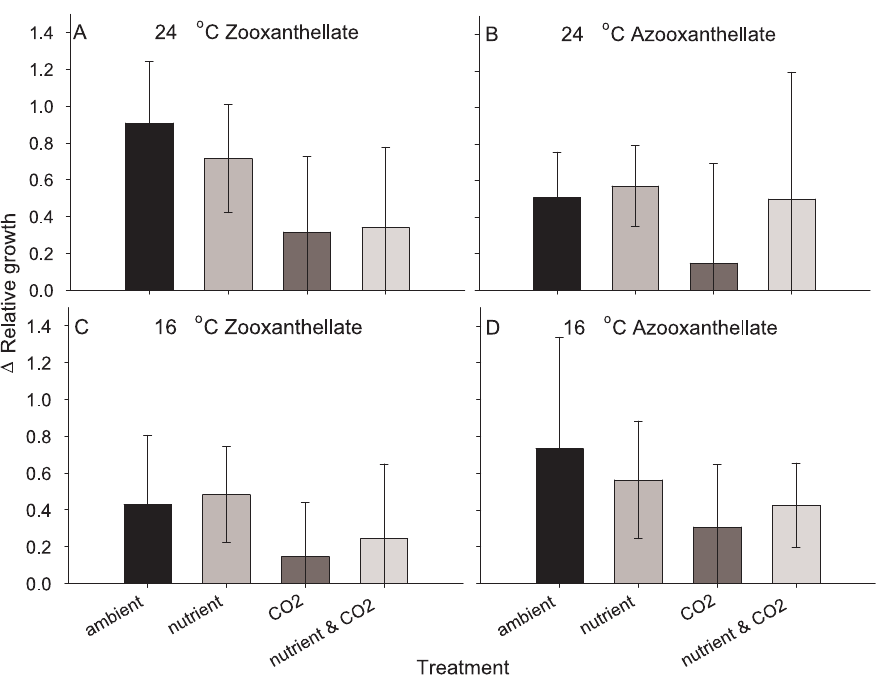
Fig. 1. Relative change in growth rate versus treatment. Zooxanthellate corals grown at 24 ◦ C (A) , azooxanthellate corals grown at 24 ◦ C (B) zooxanthellate corals grown at 16 ◦ C (C) , azooxanthellate corals grown at 16 ◦ C (D) plotted versus treatment. Bars represent means ( N = 5 for 24 ◦ C, 4 for 16 ◦ C), error bars are standard deviation.